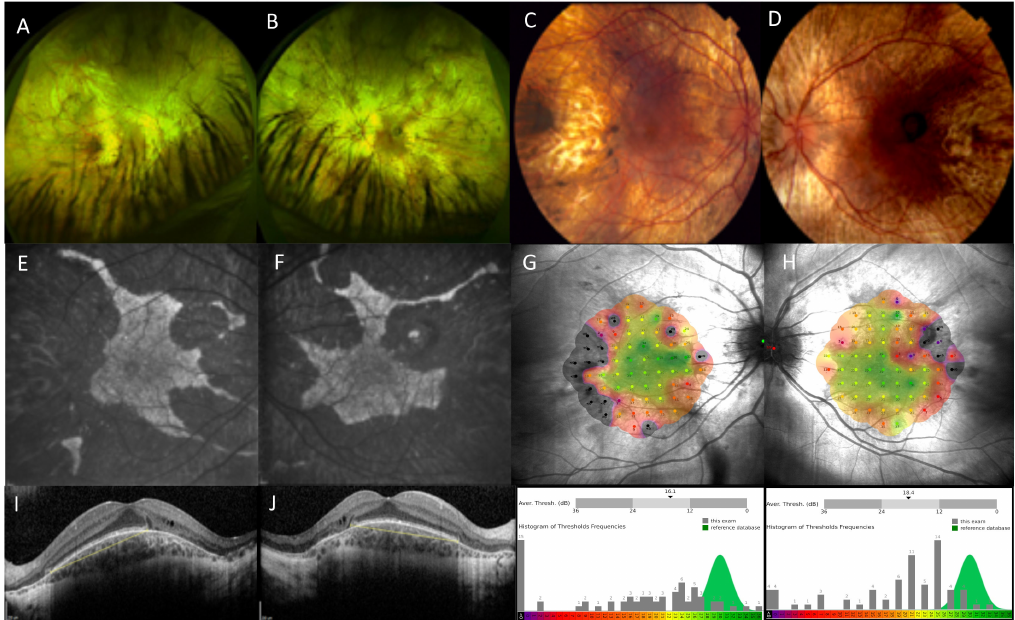
Figure 1. Retinal imaging in choroideremia. Widefield optomaps, Optos, Dumfernline, UK ( A , B ) and Heidelberg Spectralis imaging, Heidelberg, Germany ( C – F ) showing choroideremia phenotype in an a ff ected male. Colour fundus photographs ( C , D ) show extensive retinal degeneration with choroidal atrophy and visualisation of underlying pale sclera. Fundus autofluorescence ( E , F ) shows typical patterns of sharply demarcated areas of remaining tissue (hyperfluorescent) against atrophic retina (hypofluorescent background). Mesopic microperimetry, MAIA CenterVue SpA, Padova, Italy ( G , H ) measures central retinal sensitivity that closely maps areas of residual retina as seen on autofluorescence. Sensitivity maps are shown with corresponding histograms of threshold frequencies. Spectral domain optical coherence tomography, Heidelberg, Germany ( I , J ) shows retinal structure in cross-section with distribution of ellipsoid zone (yellow line) and preserved inner retinal